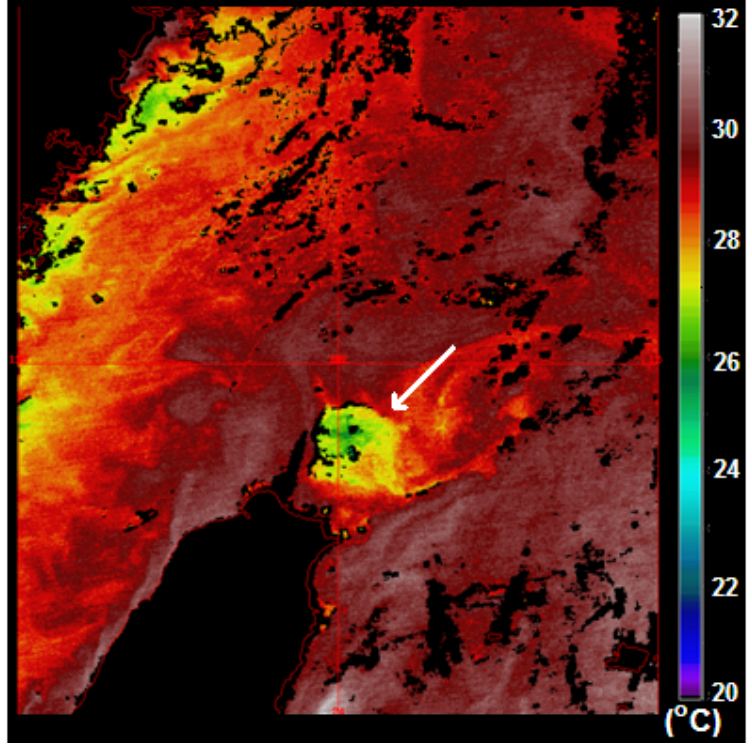
Figure 1. MODIS SST image taken on the 2nd August 2007. The white arrow indicates the cold patch off northeast